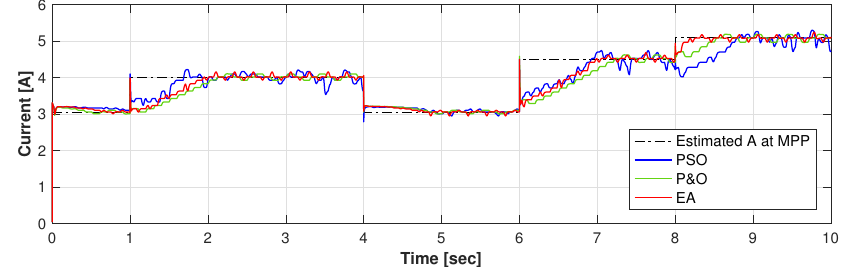
Figure 18. Current from the PV source ( i pv ) against time profiles from low power